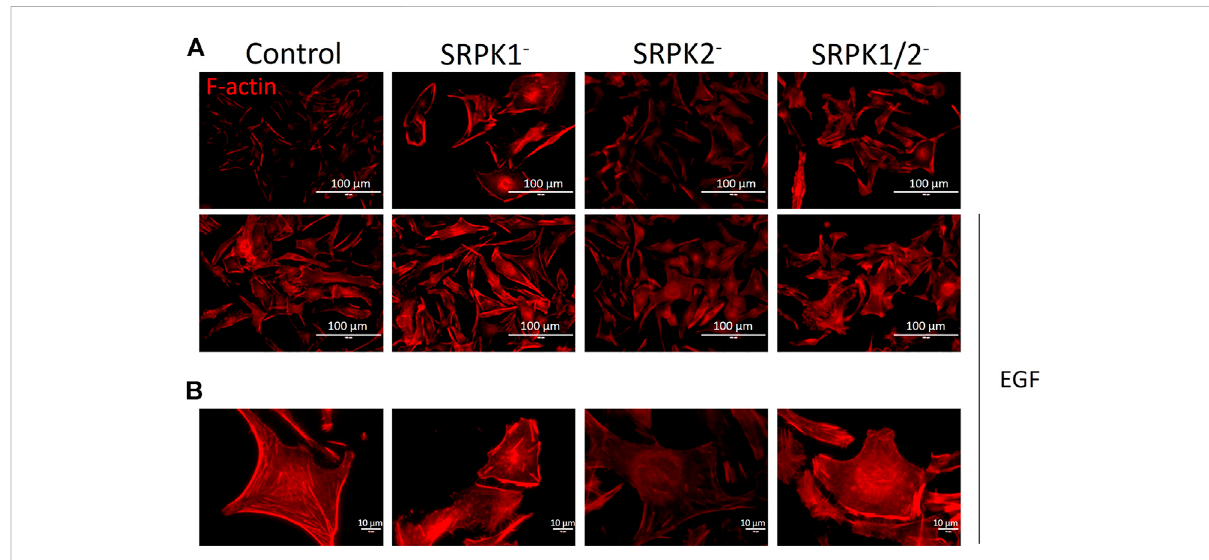
FIGURE 3 SRPK2 genetic targeting affects actin polymerization in B16F10 cells. (A) Cells were treated with EGF and then fi xed. F-actin was detected by fl uorescencemicroscopyusingRhodaminePhalloidin.Scalebar,100 µm. (B) Highermagni fi cationimagesshowingthelow fl uorescenceintensityin B16F10 SRPK2-targeted cells, indicating the lowest amount of F-actin in these cells. The scale bar 10